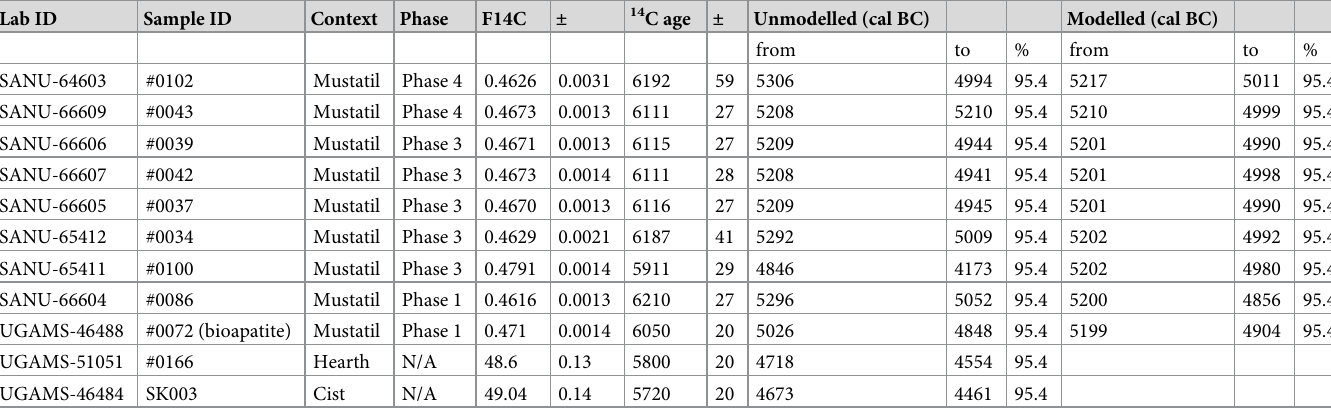
Table 3. Unmodelled and modelled (cal BC) radiocarbon data for all features within site IDIHA-0008222. Lab